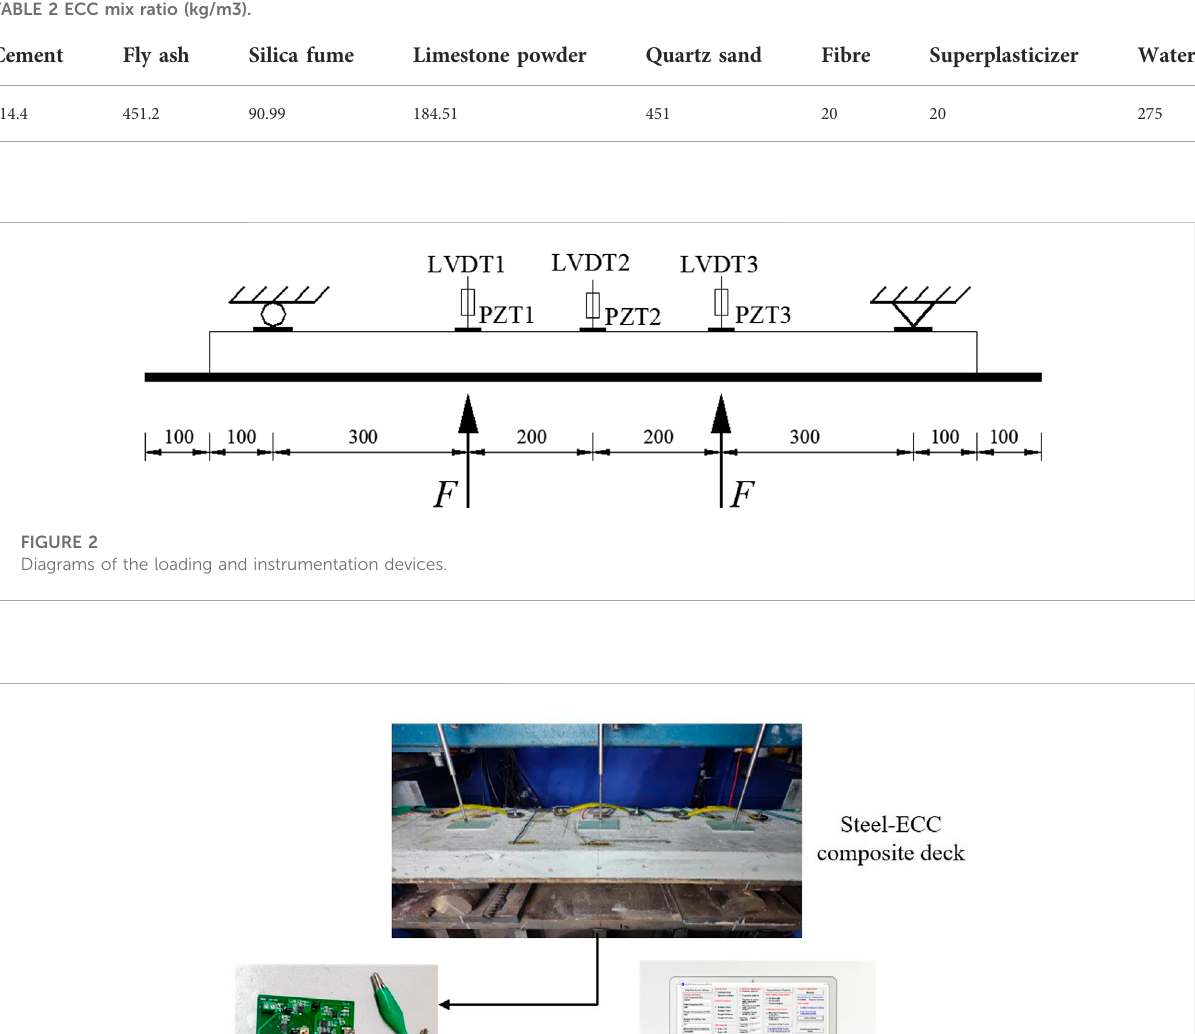
TABLE 2 ECC mix ratio (kg/m3).